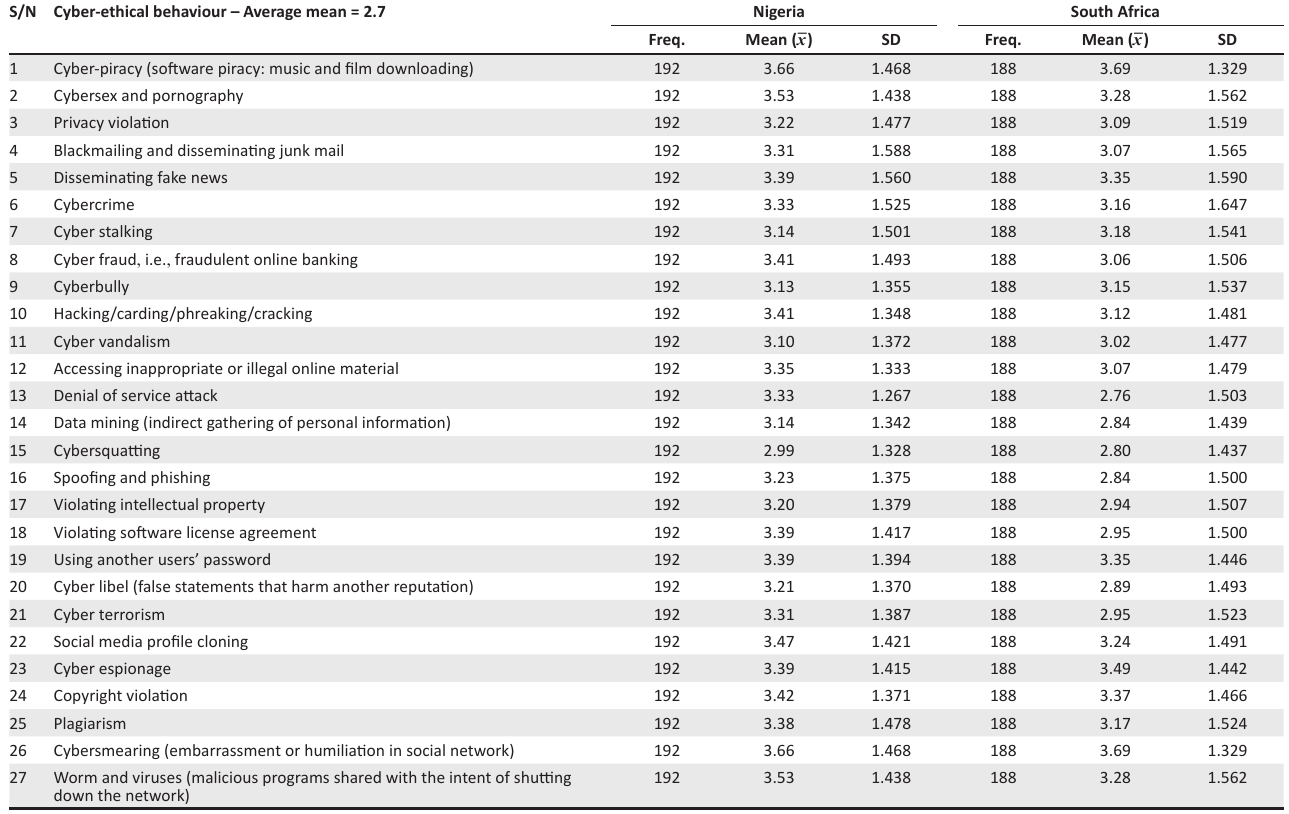
TABLE 2: Types of cyber-ethics behaviour amongst students in the two universities. S/N Cyber-ethical behaviour – Average mean = 2.7 Nigeria South Africa